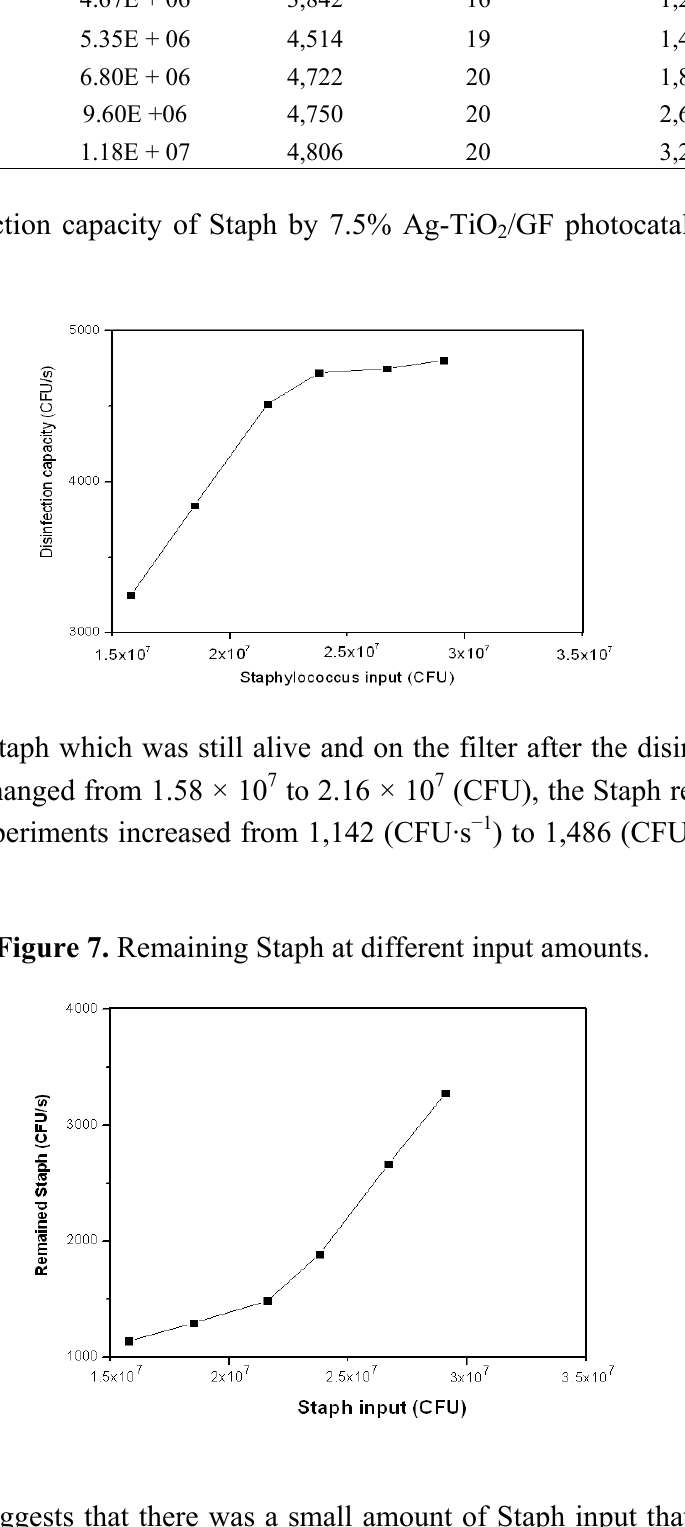
/GF with different Staph inputs. 2